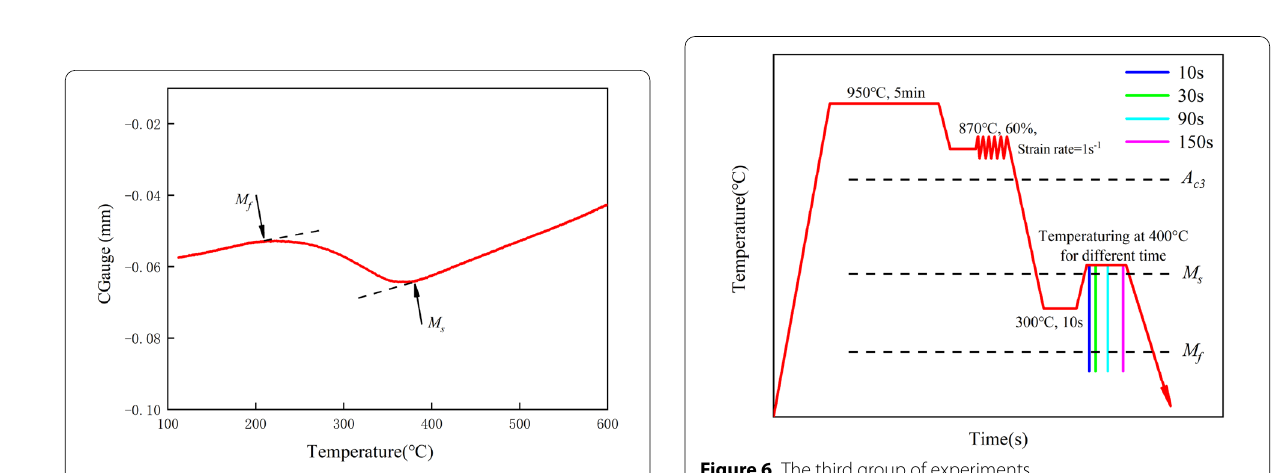
Figure 3 Martensite thermal expansion curve